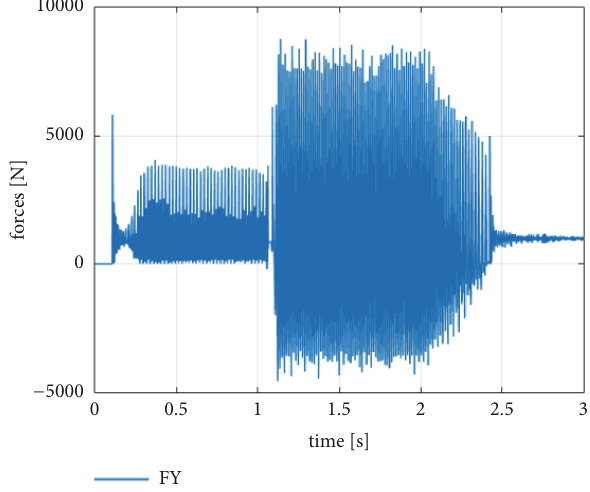
Figure 30: Predicted rotor vertical forces at DE node during a combined landing test.